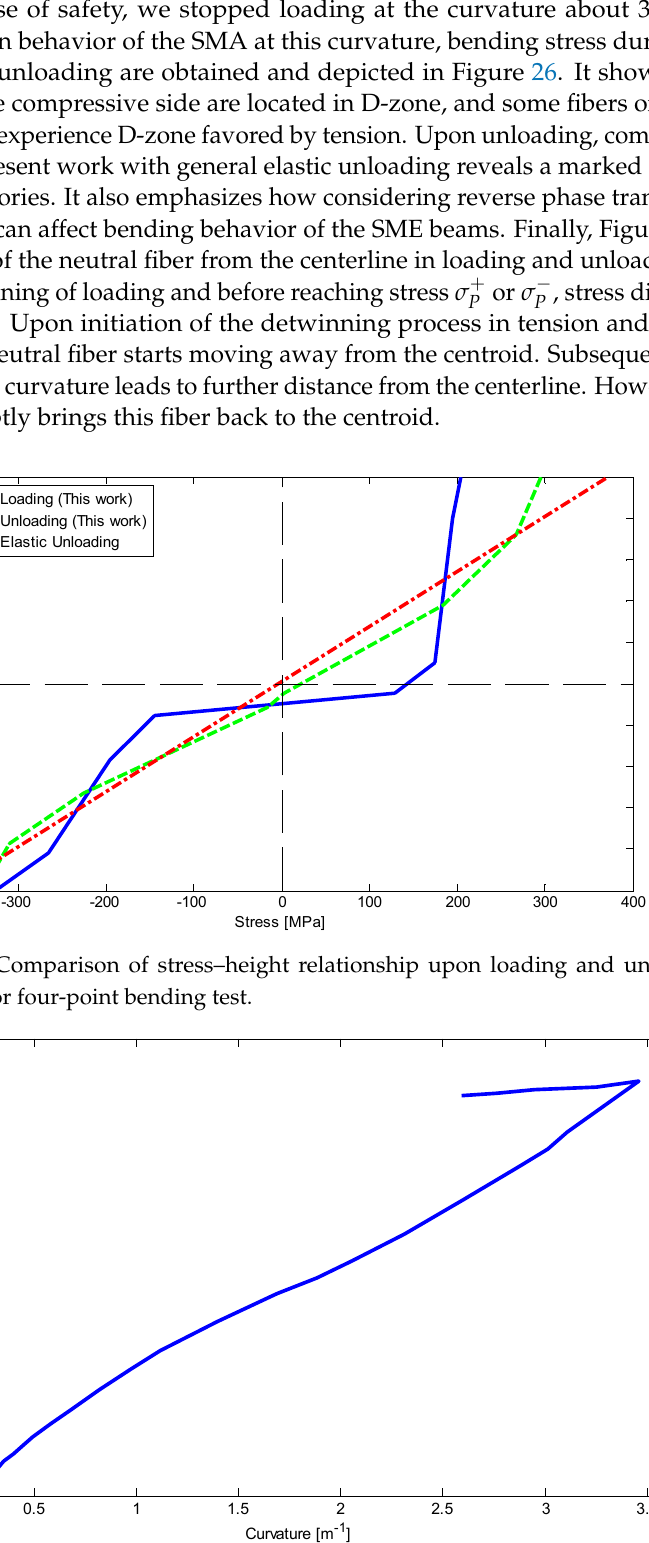
Figure 25. The relationship between deflection and length at the end of loading and unloading for the circular SMA beam under four-point bending test with the force about 19 kN.